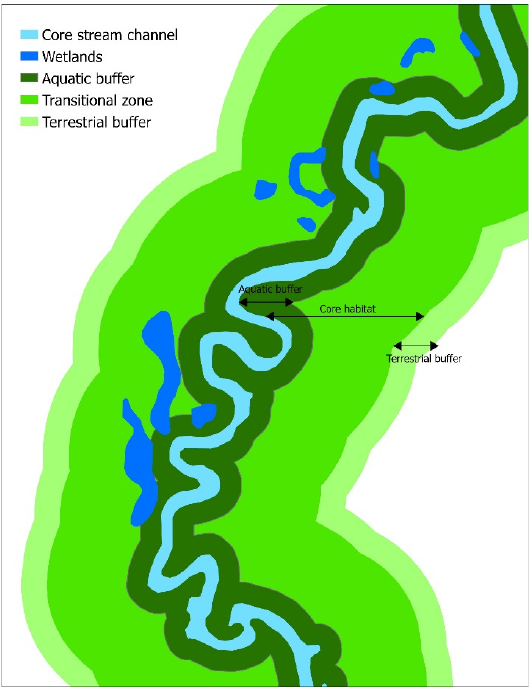
Figure 2. Fixed buffer widths applied to a single mainstem river corridor following multi-tiered buffer widths recommended by Semlitsch and Bodie [25] .